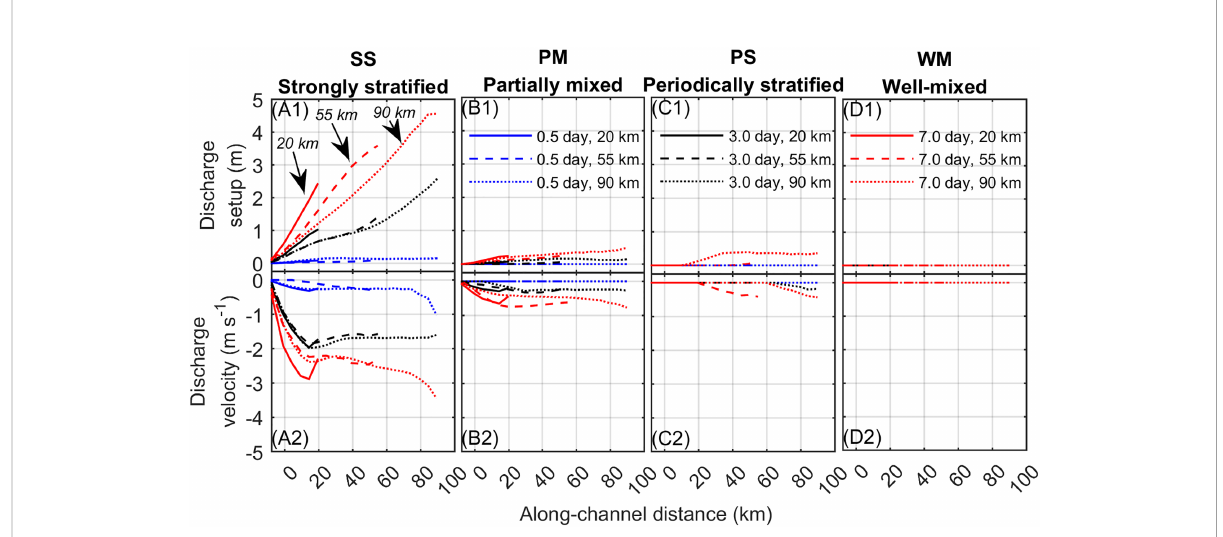
FIGURE 7 Along-channel pro fi les of (A1-D1) discharge setup (m) and (A2-D2) velocity (m s -1 ) depending on estuarine type, dam location, and discharge interval. Along-channel distance is distance from the estuarine mouth (positive landward). Negative current is